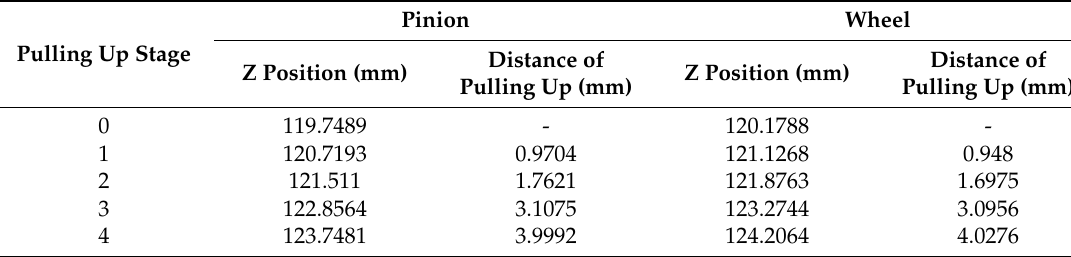
Table 2. Distance of pulling up of test gears.